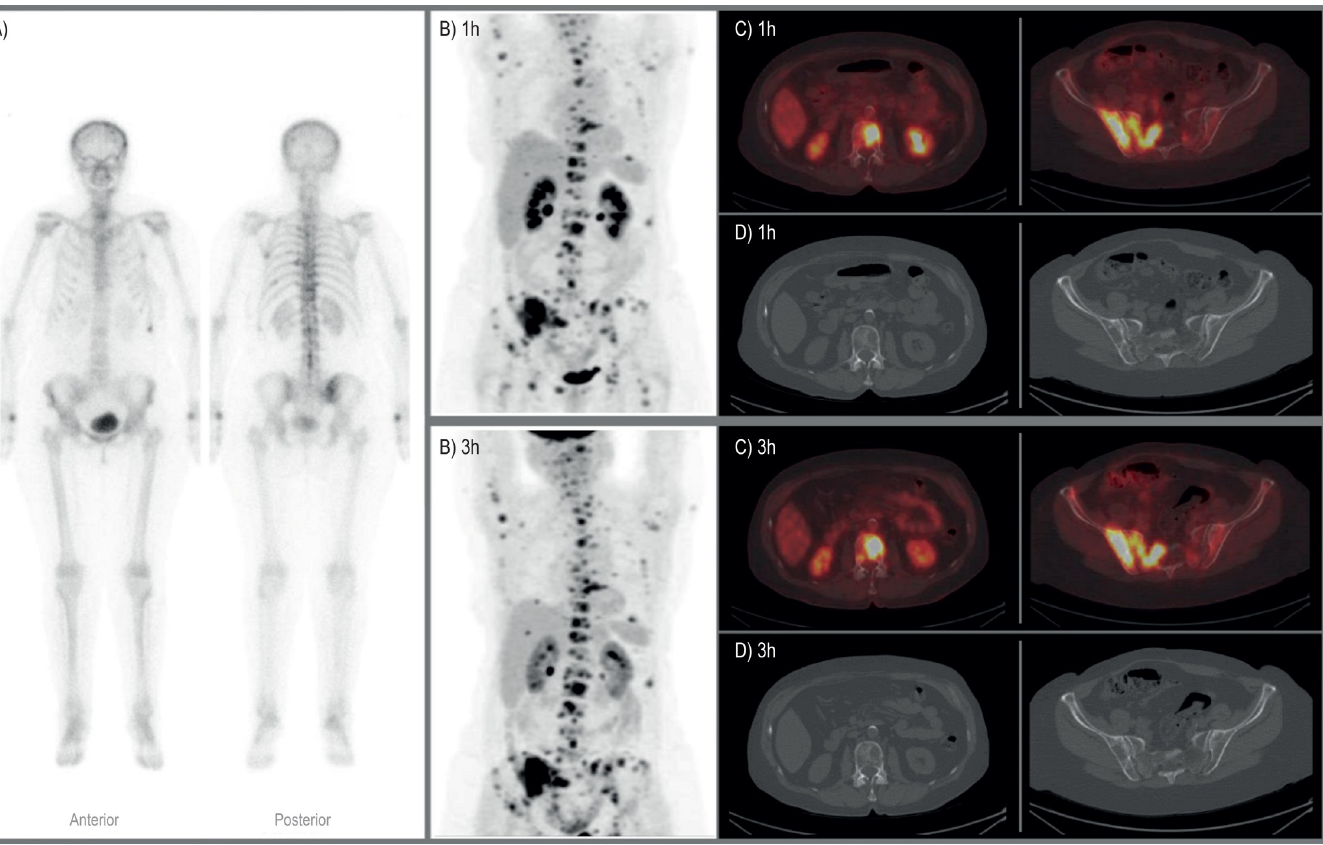
Fig 2. A 71-year-old woman with true-positive bone metastases. A) Whole-body bone scintigraphy shows few areas with increased uptake of 99mTc-DPD osteolytic lesions. B) FDG-PET images show multiple osseous metastases in the skeleton and metastases in other organs on 1h and 3h images. C) Axial 1h and 3h FDG-PET/CT images showing FDG-avid lesions in the spine, sacrum, and iliac bones. D) Axial CT images at the same level as C show osteolytic changes.